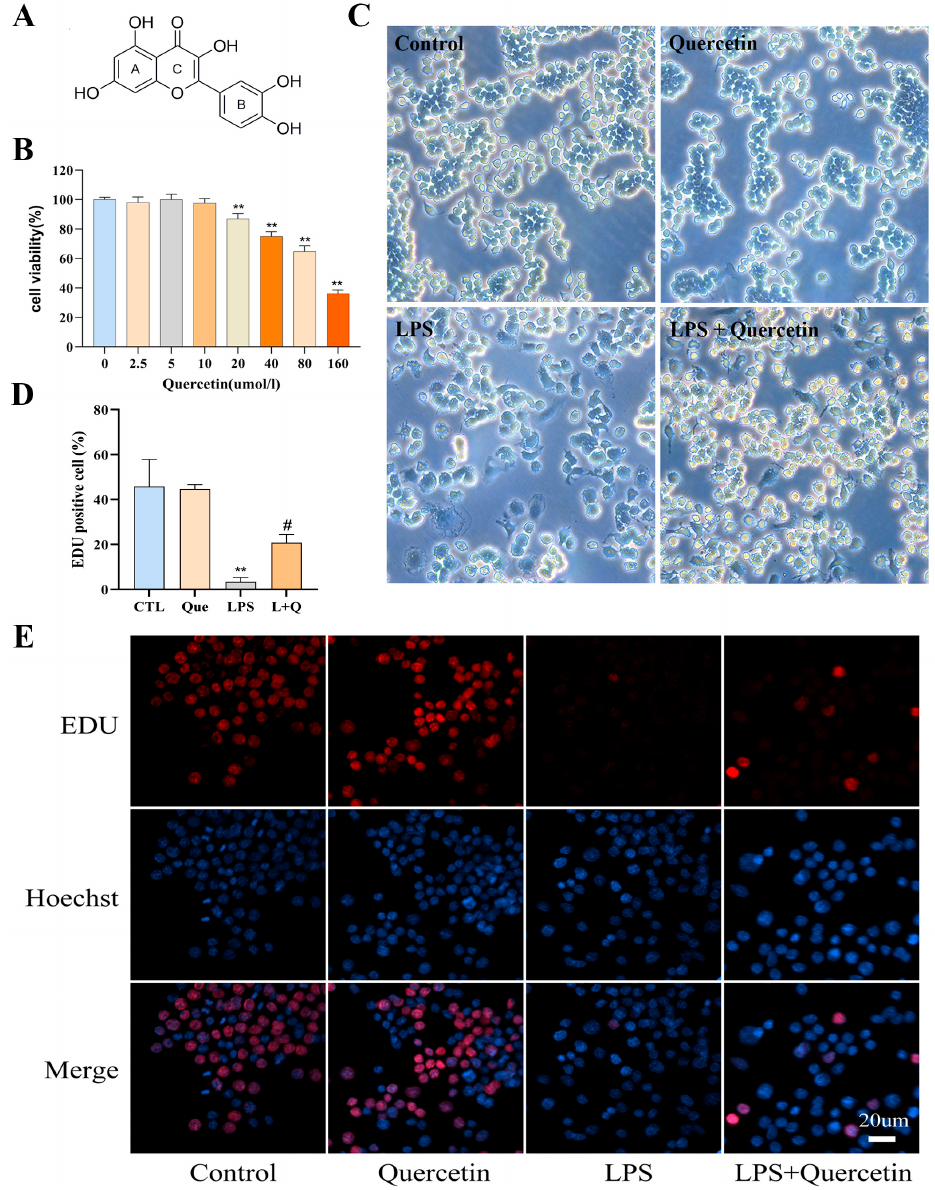
Figure 1. Effect on quercetin on RAW264.7 cells. ( A ) Chemical structure of quercetin. ( B ) The effect of quercetin on the viability of RAW264.7 cells. ( C ) The effect of quercetin on morphology of LPS ‐ induced RAW264.7 cells. ( D ) Percentage of EdU positive cells. ( E ) The effect of quercetin in the pro ‐ liferation of LPS ‐ induced RAW264.7 cells. ** p < 0.01 compared to the blank control group, and # p < 0.05 compared to the LPS group were considered statistically significant differences.